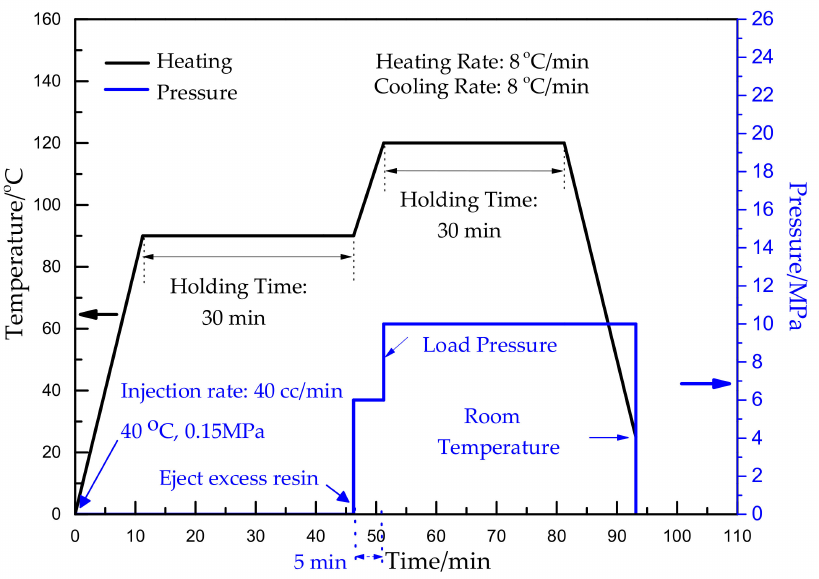
Figure 9. Subsection heating and pressurization schemes of the molding process.